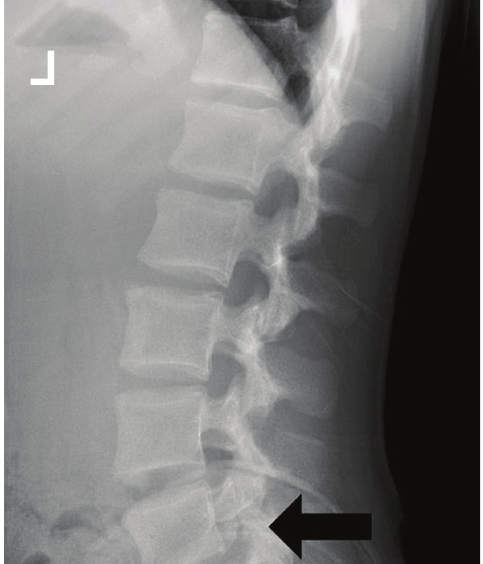
Figure 2: Hyperlucency seen at the L5 pars interarticularis is suggestive of